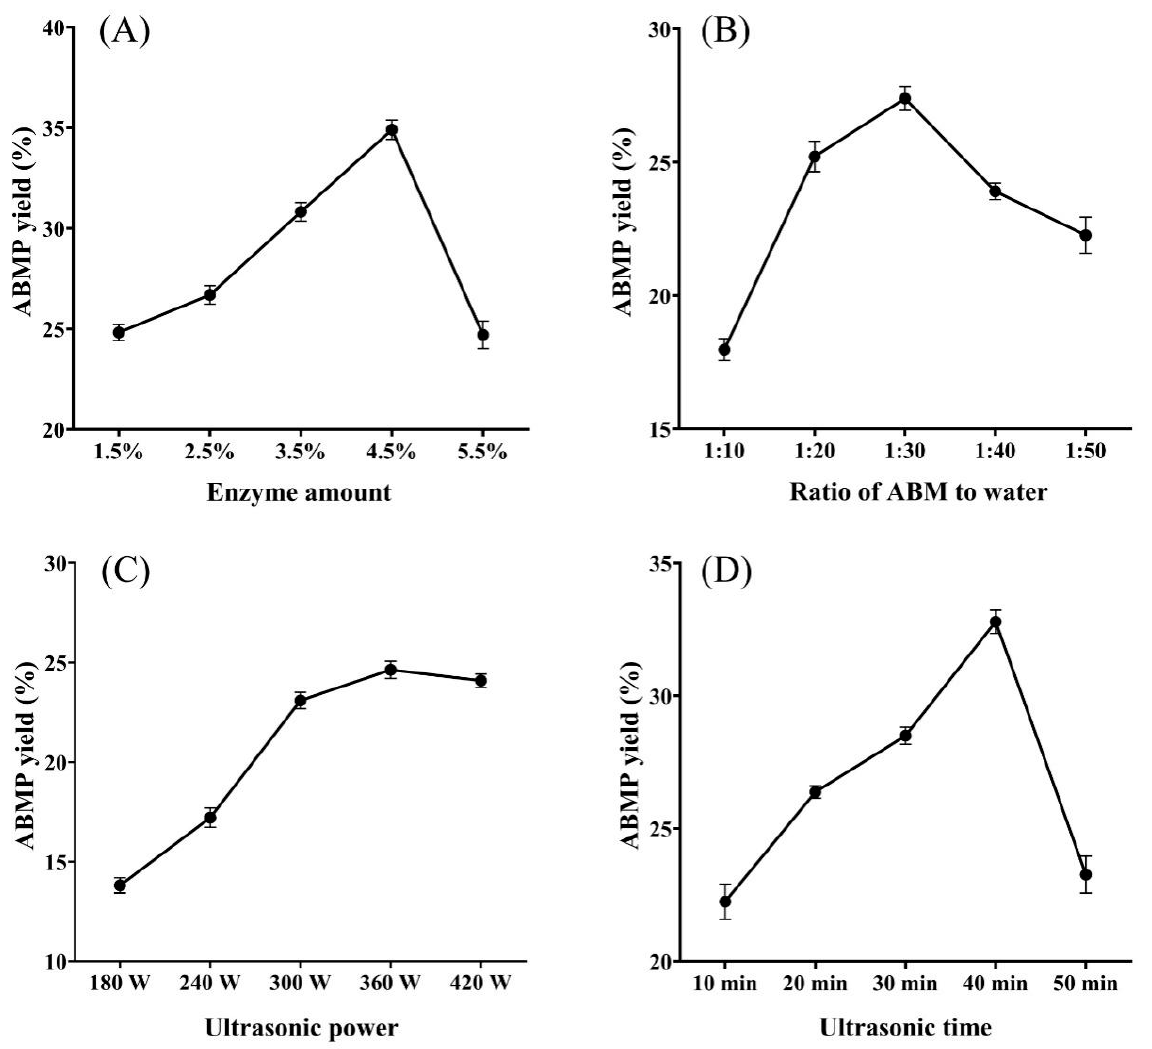
Figure 1. Effect of different extraction factors on the ABMP yield. ( A ) Enzyme amount; ( B ) ratio of ABM to water; ( C ) ultrasonic power; ( D ) ultrasonic time.